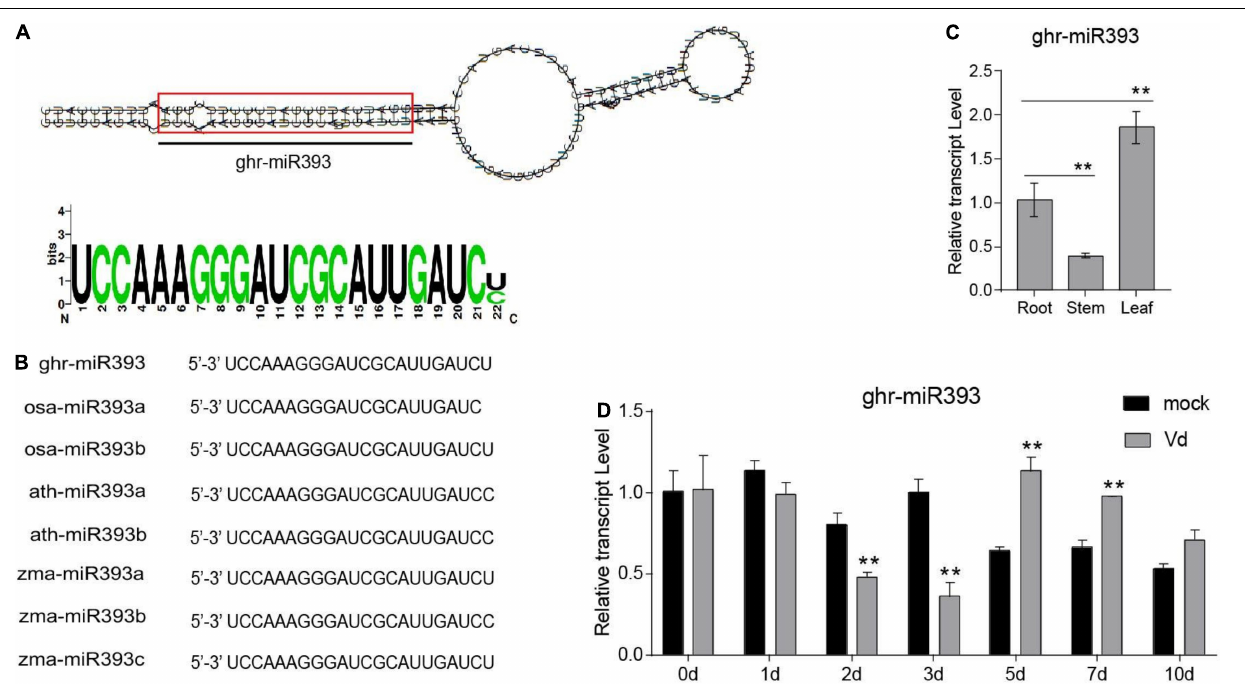
FIGURE 1 | Ghr-miR393 characteristics and expression profiles. (A) Precursor of stem-loop structure of ghr-mir393. (B) The sequence alignment of ghr-mir393 and other miR393s of Oryza sativa , Arabidopsis thaliana , and Zea mays . (C) The tissue expression profile of ghr-mir393. (D) The expression profile of ghr-mir393 in plants inoculated with Verticillium dahliae . GhU6 was used as a reference gene. The error bars indicate the SD of three biological replicates. Statistical significance was determined by Student’s t -test, as compared with the mock treatment, ** P < 0.01.